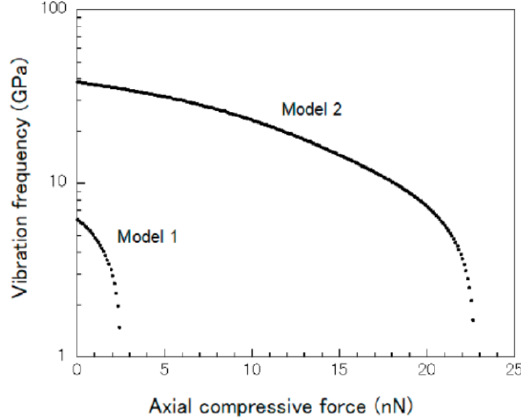
Figure 9. Relationship between the external compressive force and the frequency of the partial embedded carbon nanotubes resonator